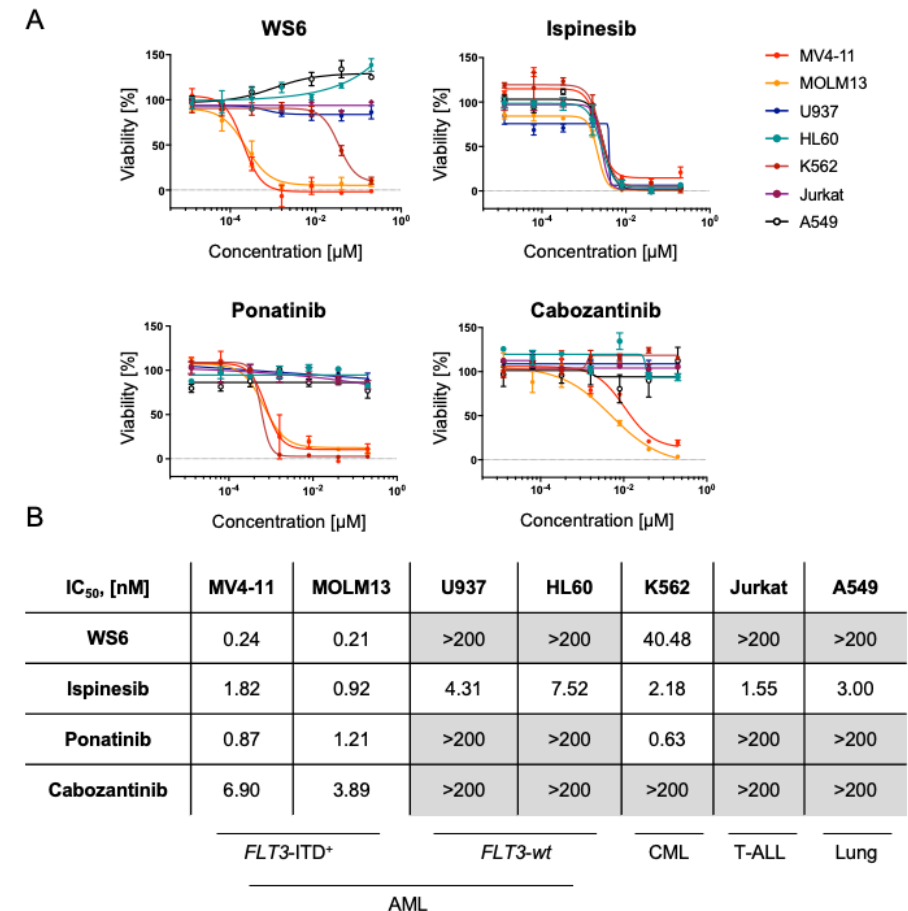
Figure 2. Selectivity of chosen compounds in various AML, CML and negative control cancer cell lines. ( A ) Cytotoxicity assays of leukemia cell lines treated with the indicated compounds for 72 h. Each cell line was treated with the compound of interest and the viability was determined using CellTiter-Blue ® (Promega). Jurkat and A459 cancer cell lines serve as negative controls. Representative dose-response curves are shown, error bars represent mean +/ − SEM, n = 3. ( B ) Average IC 50 values of cell lines treated with WS6, ispinesib, cabozantinib, or ponatinib. Values above 200 nM are depicted in grey.